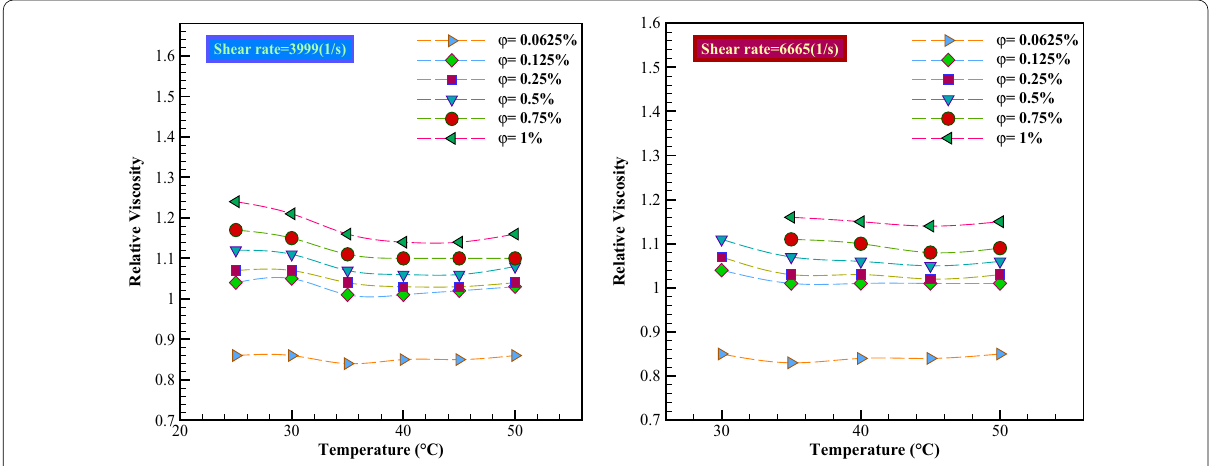
Fig. 8 Relative viscosity in terms of φ at different temperatures and γ